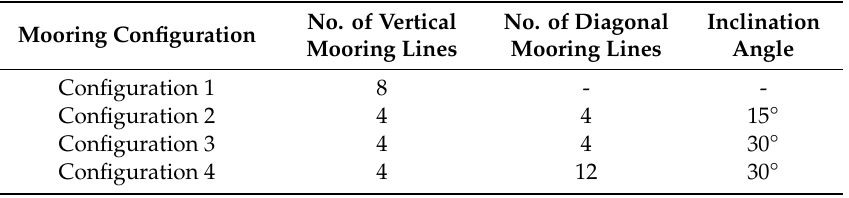
Table 5. Mooring